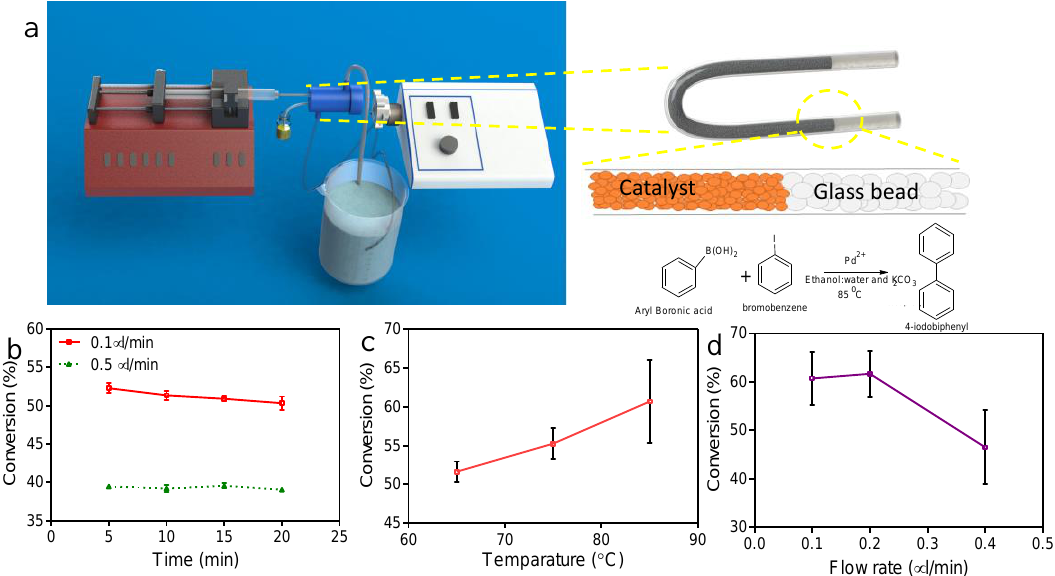
Figure 8. Suzuki-Miyaura reaction in the microreactor. ( a ) Microreactor set up ( b ) Velocity effect on conversion rate for 4-Iodo toluene and ethanol as solvent at 65 °C during time ( c ) Temperature effect on conversion rate for 4-Iodo toluene and ethanol as solvent at initial velocity of 0.1 µL/min ( d ) Velocity effect on conversion rate for 4-Iodo toluene and ethanol as solvent at 85 °C (n = 3).